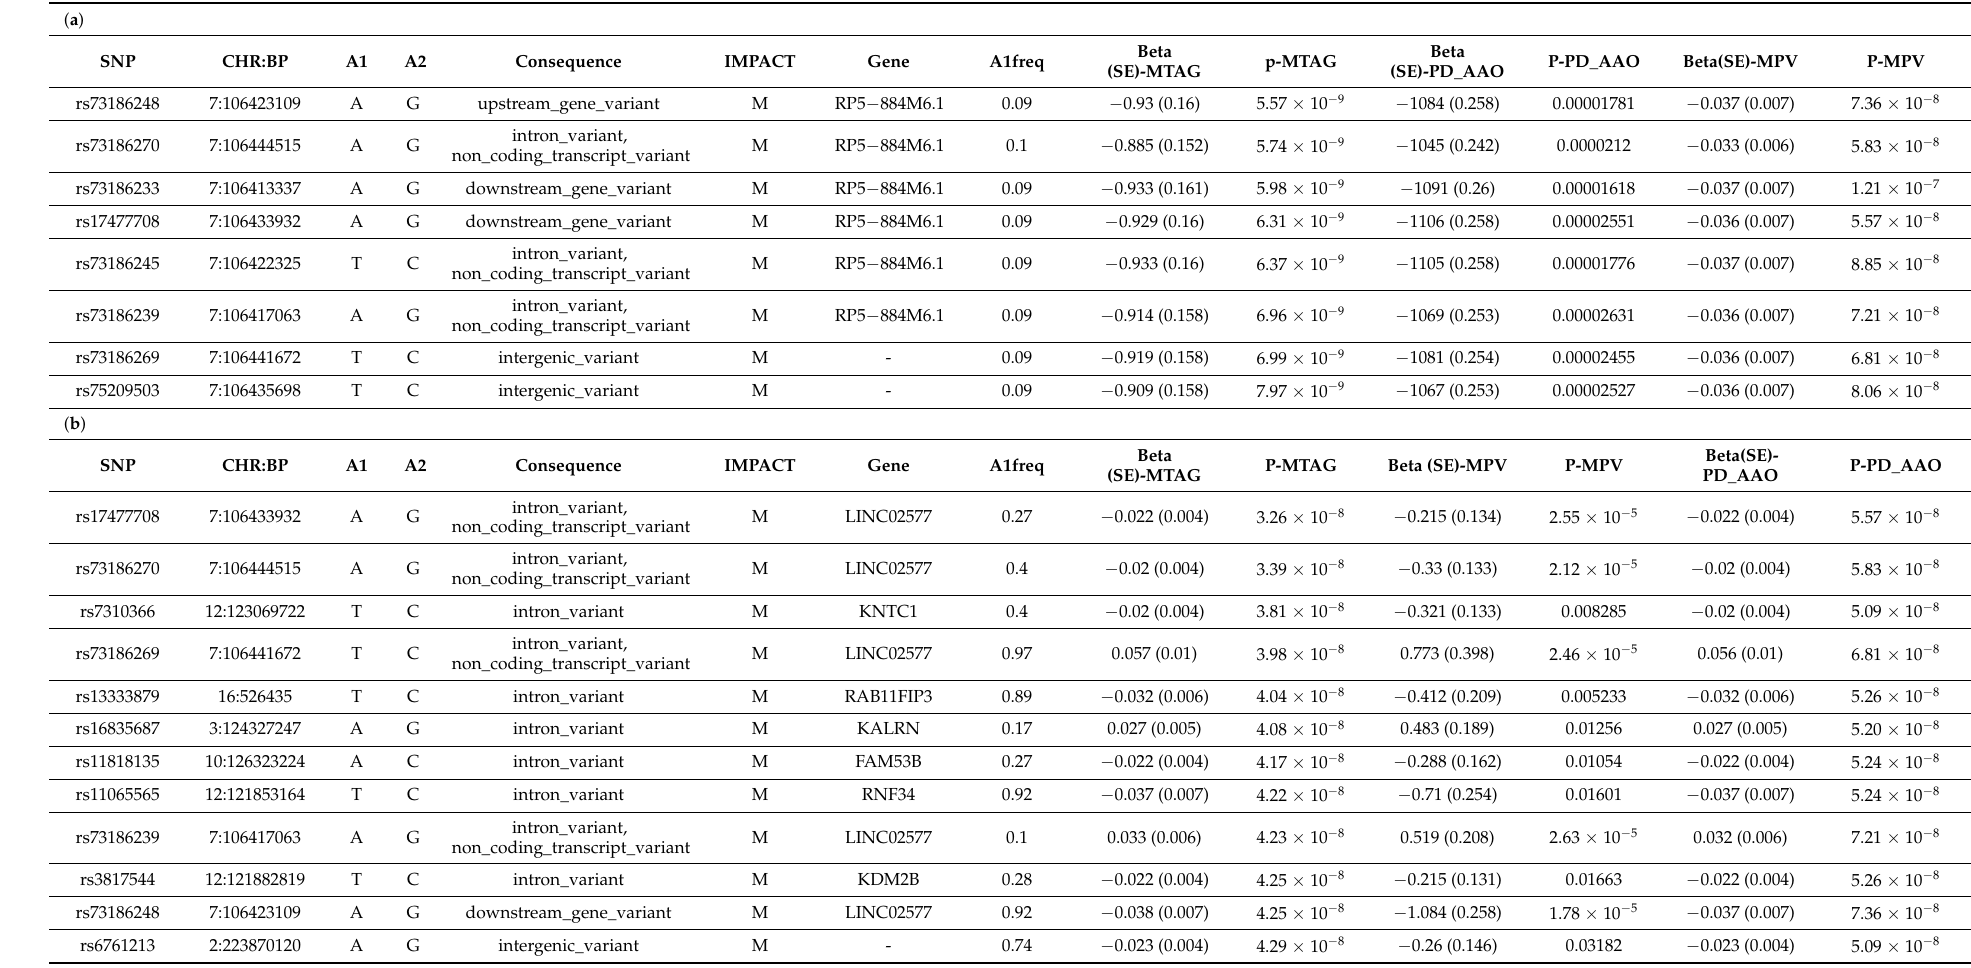
Table 2. Novel variants associated with ( a ) PD-AAO and ( b ) MPV in a multitrait association test with